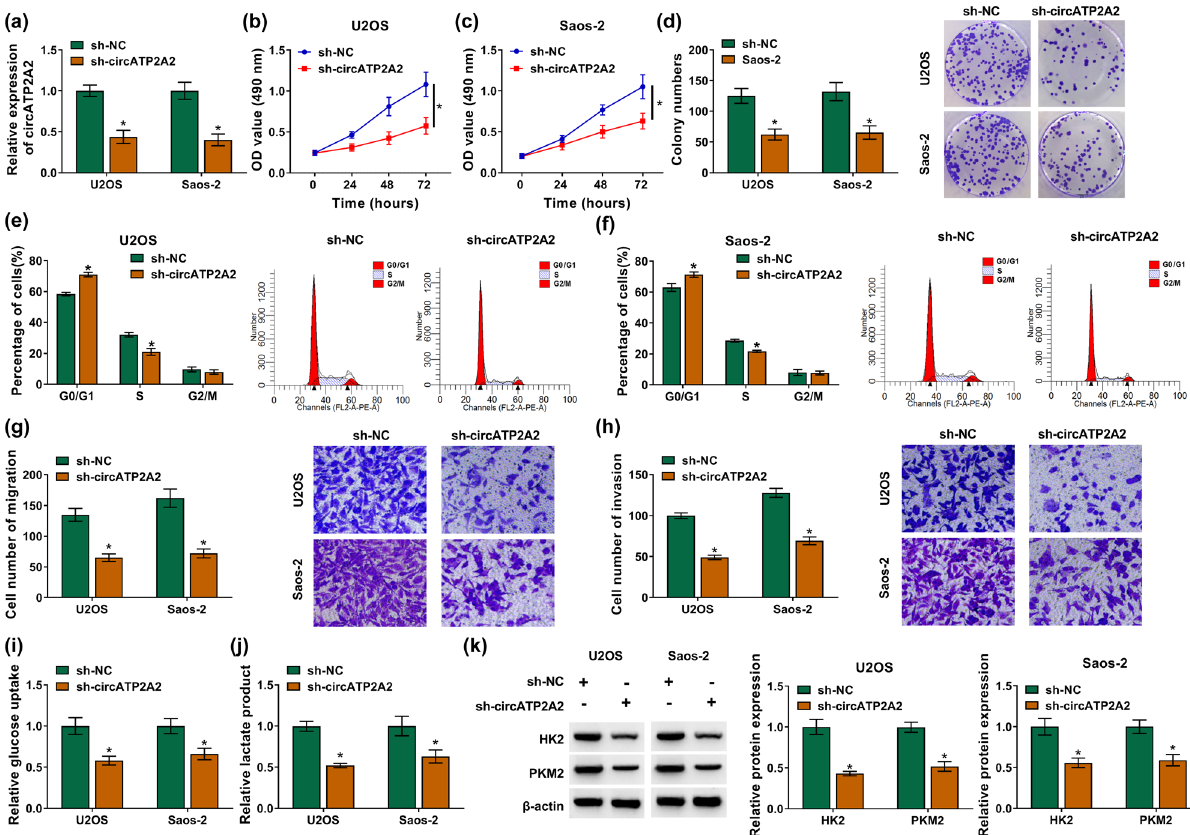
Figure 2: circATP2A2 promoted OS cell malignancy and glycolysis. ( a – k ) OS cells were transfected with sh - NC or sh - circATP2A2. ( a ) The interference e ffi ciency of sh - circATP2A2 in OS cells was veri fi ed by RT - qPCR. ( b – h ) The proliferation, cell cycle progression, migration, and invasion of OS cells were evaluated by MTT, plate clone, fl ow cytometry, and transwell assays, respectively. ( i and j ) Assessment of glucose uptake and lactate product levels in OS cells. ( k ) Detection of protein levels of HK2 and PKM2 in OS cells by western blotting. * P <